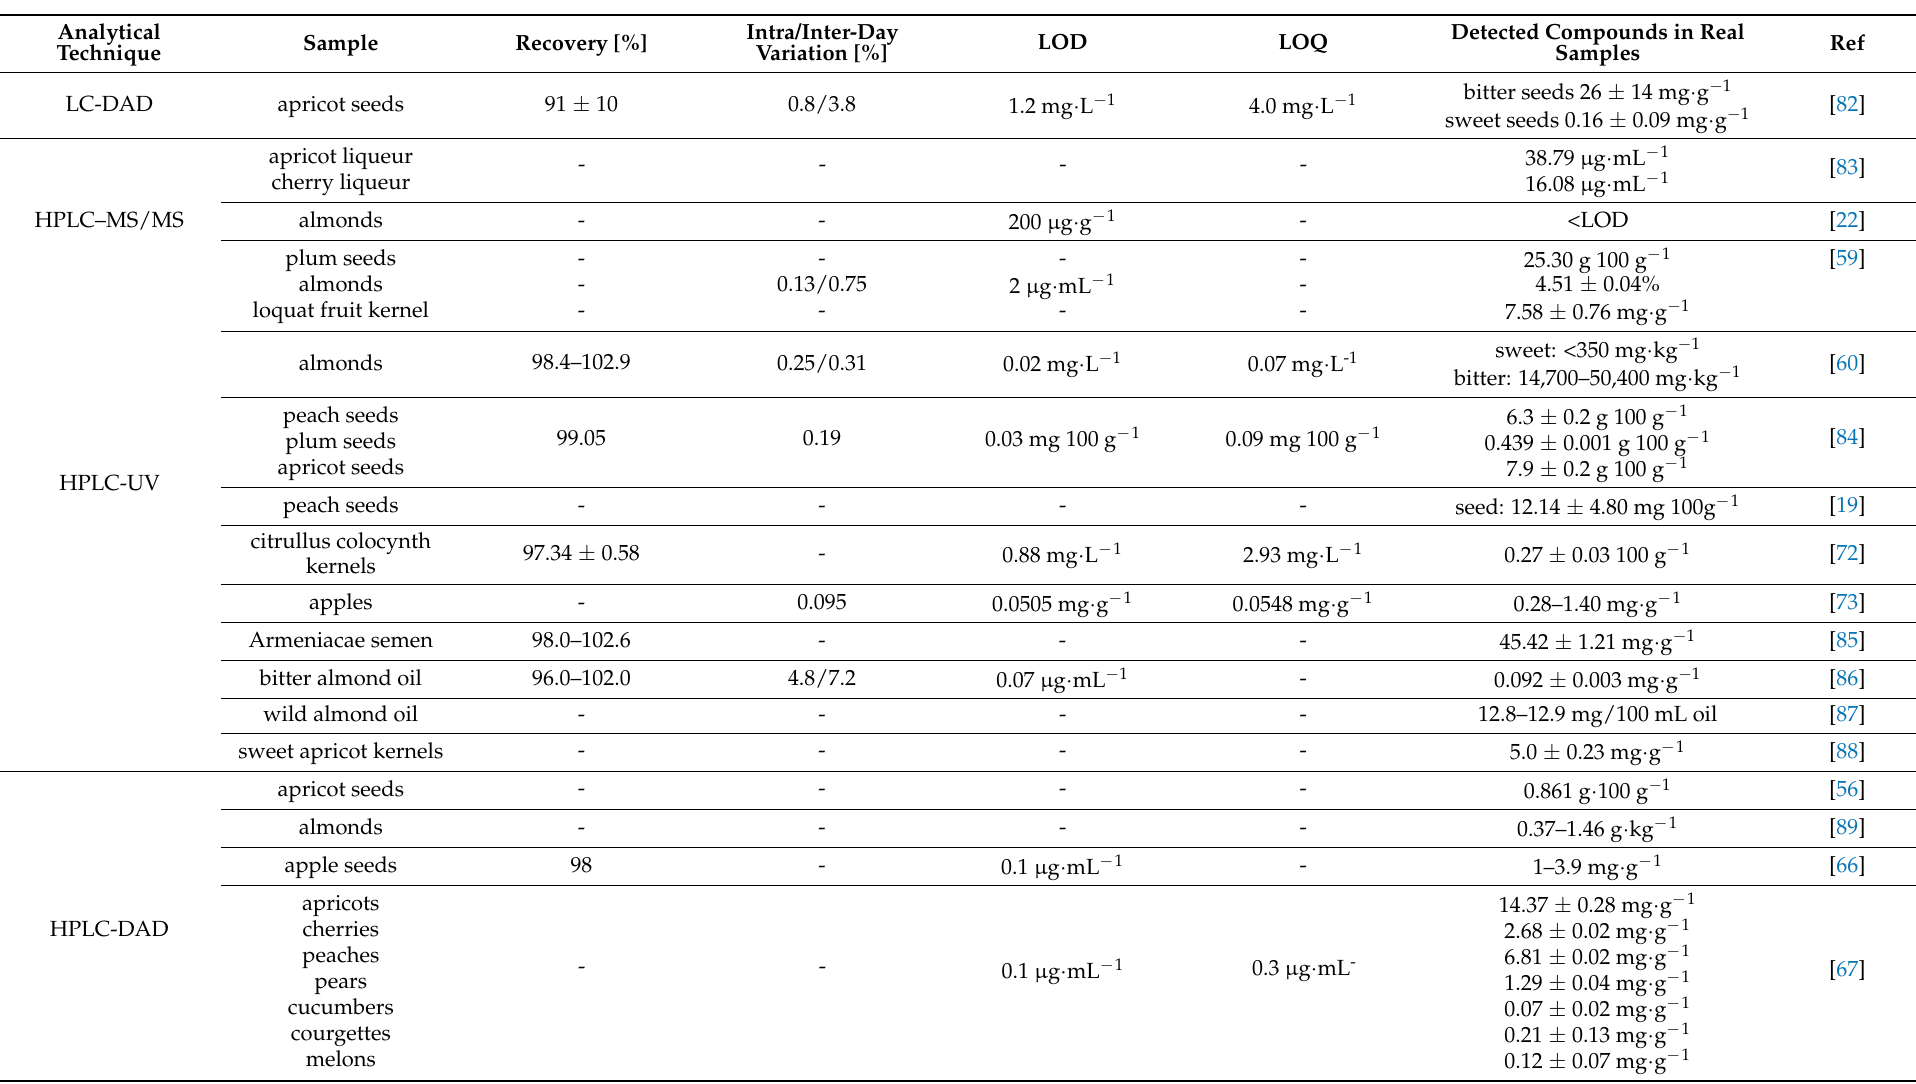
Table 5. Total amygdalin content in different